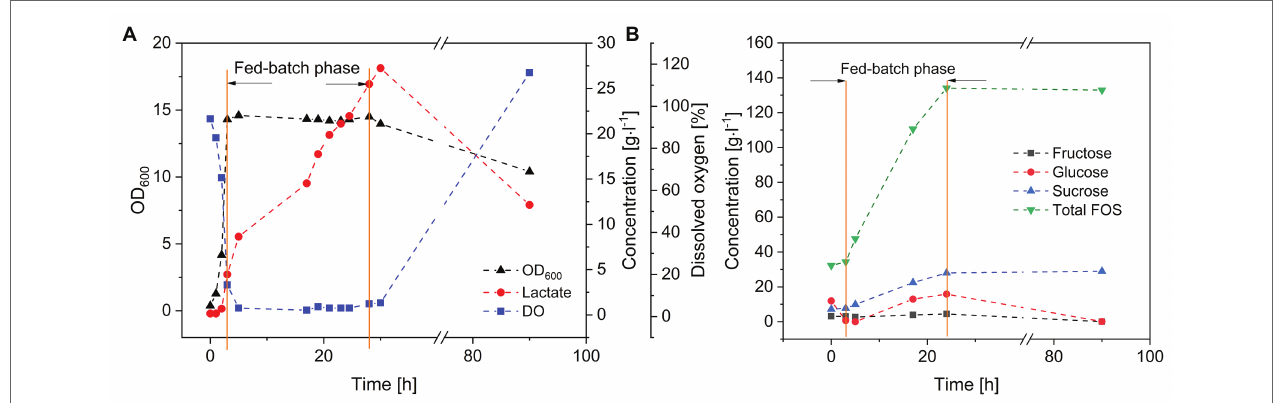
FIGURE 5 | Fed-batch fermentation of B. subtilis in a 3-L stirred-tank bioreactor. Feeding rate of FOS solution = 20 ml·h −1 , T = 40 ° C, pH = 6.8, and aeration = 0.5 vvm. (A) Bacillus subtilis growth kinetics and product formation, and (B) purification of FOS during the fermentation.